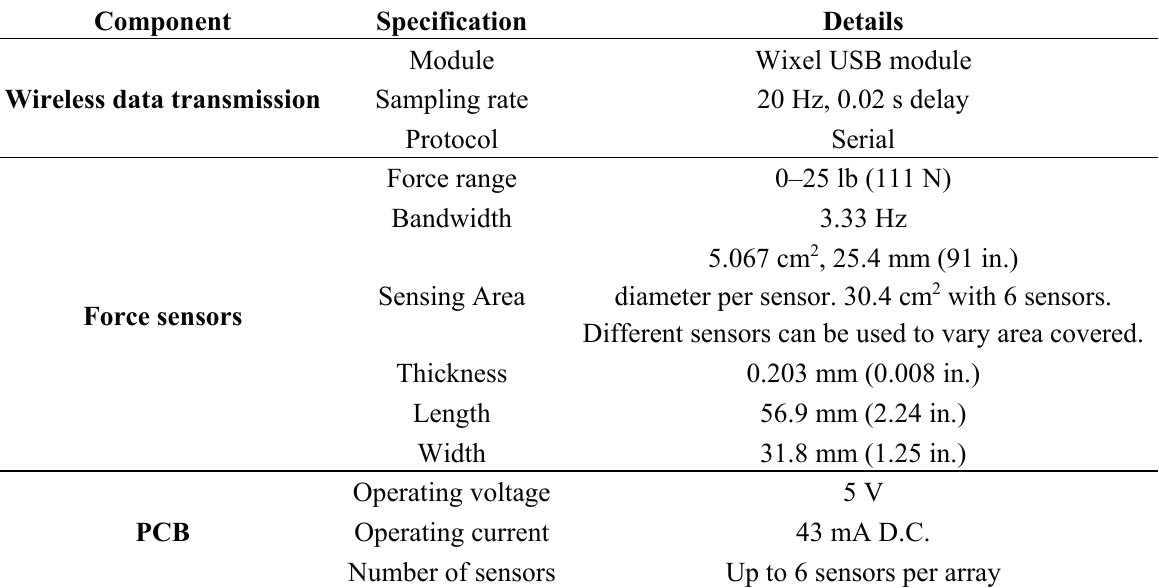
Table 1. Technical specifications of pressure sensor